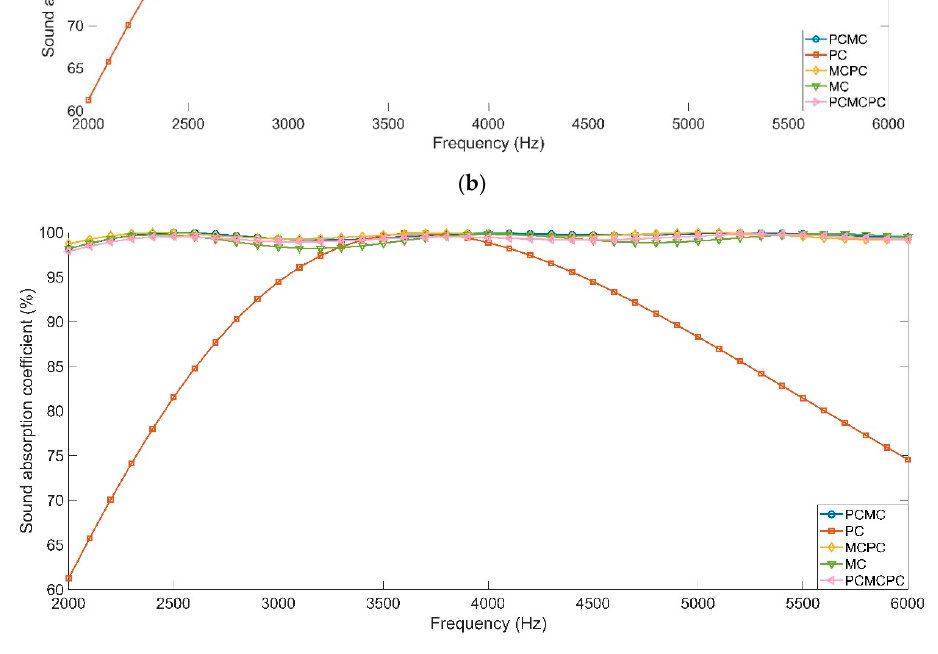
Figure 4. Distributions of sound absorption coefficients of the optimal composite structures in theory. ( a ) Composite structures with limited total thickness 30 mm corresponding to parameters in Table 3; ( b ) composite structures with limited total thickness 50 mm corresponding to parameters in Table 4; ( c ) composite structures with limited total thickness 100 mm corresponding to parameters in Table 5. Table 3. Summarized optimal parameter of composite structure with limited total thickness 30 mm.